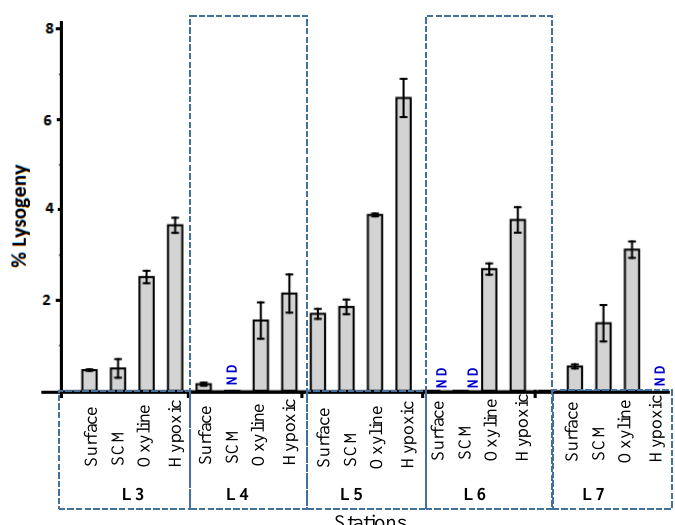
Figure 6. Percentage lysogeny at various oxygen concentrations, surface, SCM, oxycline, and hypoxic layers at stations L3, L4, L5, L6 and